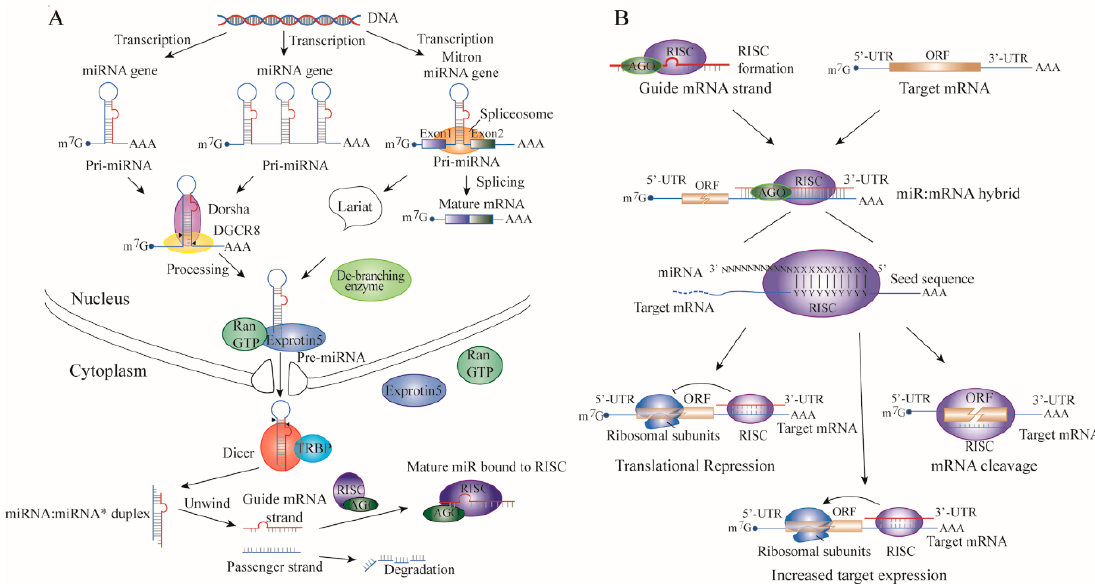
Figure 1. Steps involved in the biogenesis and functions of miRNAs. ( A ) The miRNAs’ synthesis and maturation pathway. MiRNAs are transcribed by RNA polymerase II enzyme as about 500–3000 nucleotides-long pri-miRNA capped with 7-methylguanosine at its 5’-end and polyadenylated tail at the 3’-end. The pri-miRNAs form a specific secondary structure of hairpin-shape and stem–loop, and are then cleaved by the RNase III family enzymes Drosha-DGCR8 based on the stem–loop structure, which cleaves 11 base pairs away from the single-stranded stem–loop junction to shorten the pri-miRNA to 60–70 nucleotides with double helix hairpin structure to yield the pre-microRNA that contains a 5’-phosphate group and 2–3 nucleotides overhang stretch at the 3’-end. Then, the pre-miRNA is exported to the cytoplasm by the shuttle protein Exportin-5 in an Ran-GTP-dependent manner, where the pre-miRNA is cleaved by the endonuclease cytoplasmic RNase III enzyme Dicer to yield an approximately 22 nucleotides dsRNA with two-nucleotide 3’-overhang miRNA:miRNA* duplex in concert with TRBP or PACT cofactors. The miRNA:miRNA* duplex unwinds by cytoplasmic helicase and one of the strands is defined as a mature miRNA, and miRNA* is quickly degraded. The mature miRNA, AGO2, and other proteins are incorporated into the RISC to form an miRISC. ( B ) The mechanisms of miRNA action. The activity of mature miRNAs binding to the target mRNA sequence occurs in a perfect or, most often, in an imperfect manner. The complementarity binding is usually restricted to the 5’-end nucleotides 2–8 of the miRNA, termed “seed sequence”, with the mRNA complementary sequences at 3’-UTR. Due to decreased steric hindrance, the perfect miRNA:mRNA complementarity usually lead to degradation of the mRNA by AGO2 via the small interfering RNA (siRNA) pathway and is referred to as “slicer activity”. The imperfect pairing with mRNA causes the RNA-Polymerase to become blocked and leads to the low-level efficiency of mRNA transcription at the initiation, or elongation and termination. In addition, the miRNAs can bind the promoter regions and the coding regions to upregulate the translation of their target mRNA, but this is in the minority. Each miRNA has multiple targets, while the same gene can also be influenced by several